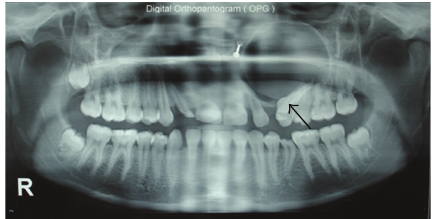
Figure 2: Oral pantomogram showing well-defined radiolucent cyst with canine tooth (arrow).